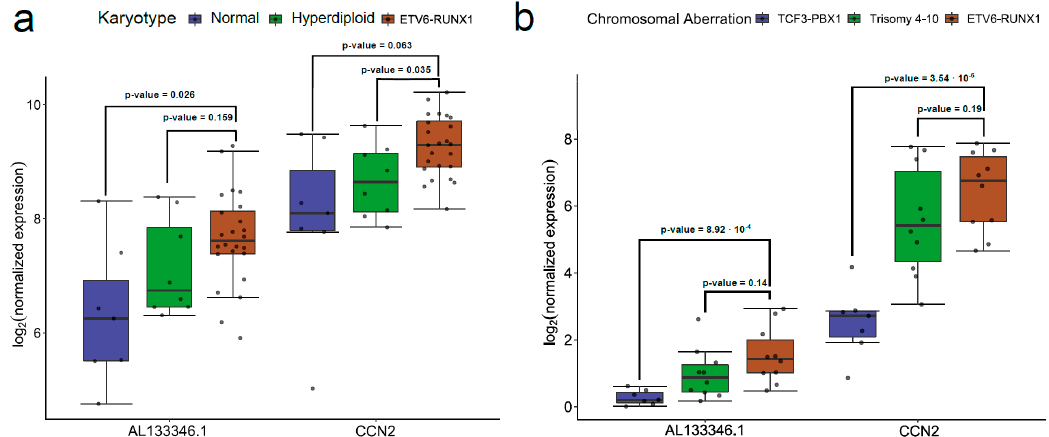
Figure A1. Gene Ontology (GO) analysis of the mRNAs associated with the differentially expressed lncRNAs between pediatric B ‐ ALL and healthy samples. The top 10 significantly enriched upregulated ( a ) and downregulated ( b ) GO terms are shown. Only non ‐ redundant GO terms are included as described in Methods.